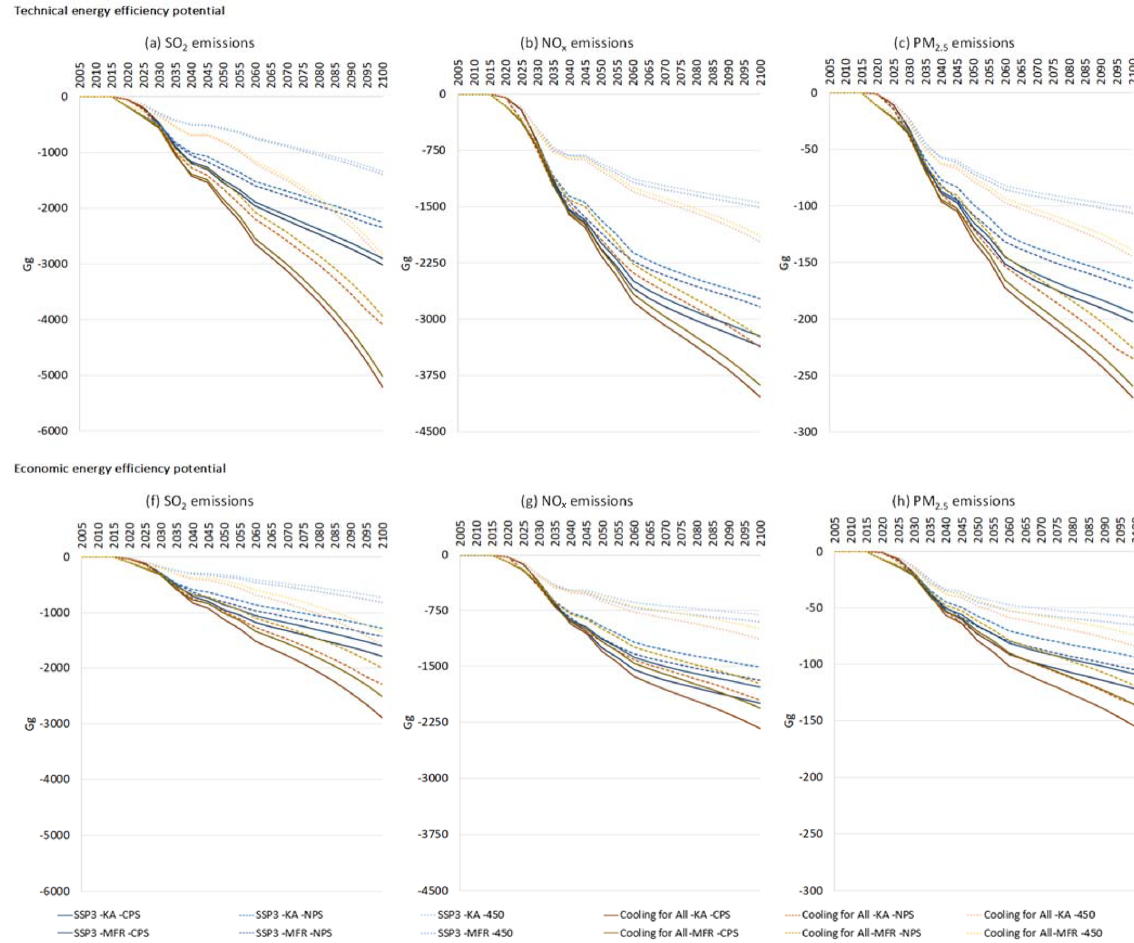
Figure 8. Impacts on air pollutant emissions due to electricity savings associated with alternative HFC phase-down